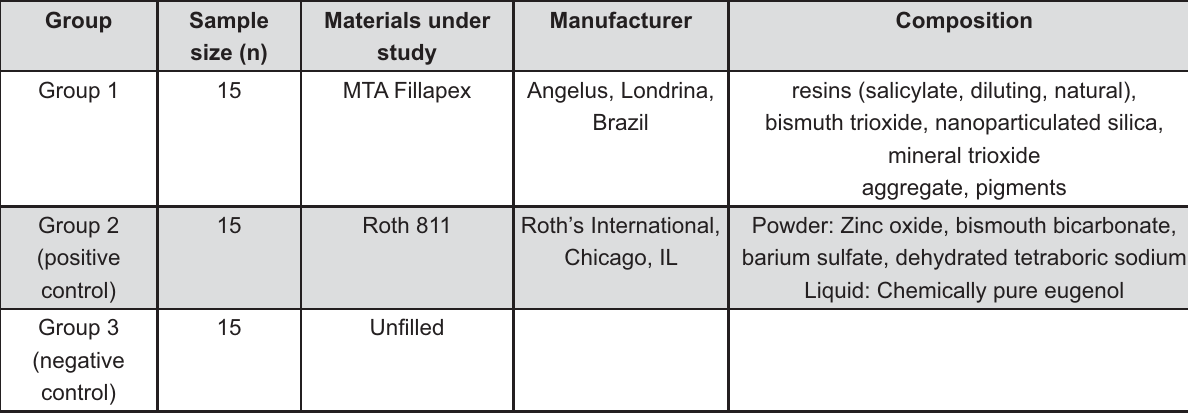
Figure 1- Study groups